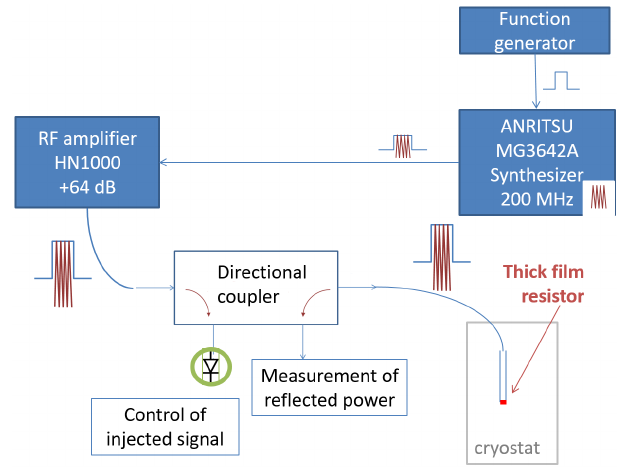
FIG. 10. Experimental setup for the generation and control of the heat